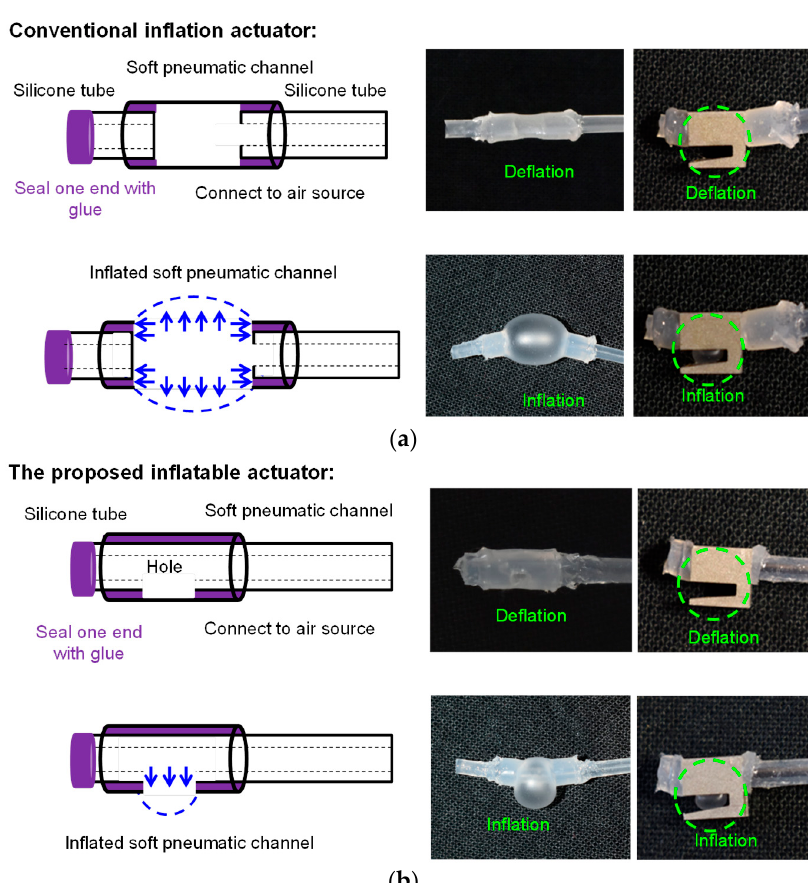
Figure 3. Two types of soft inflatable actuators: ( a ) the whole soft pneumatic channel is inflated by a silicone tube; ( b ) the membrane surface of the soft pneumatic channel is inflated by a hole in the silicone tube. Micromachines 2019 , 10 , x FOR PEER REVIEW